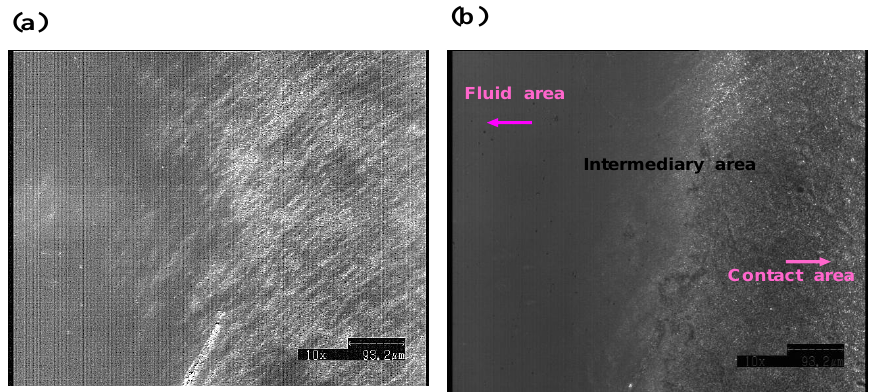
Figure 10. CLSM images with optical-isolator technique about the intermediary area. The reflection image (a) was obtained corresponding to the third area in the original CLSM image